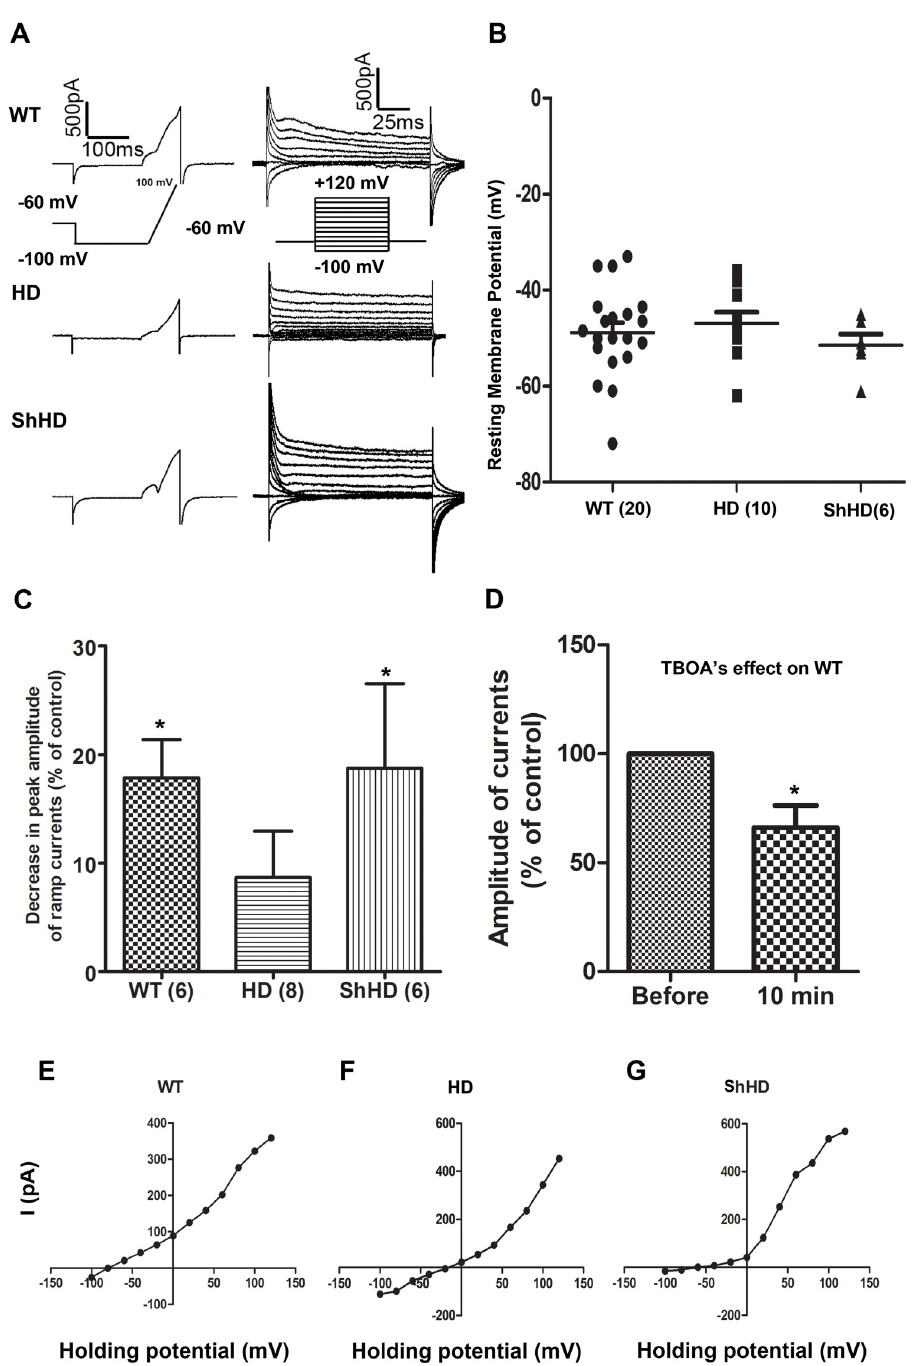
Fig 5. Functional characterization of differentiated astrocytes. (A) Representative traces of ionic currents evoked by ramp protocol (left) and voltage-step protocol (right) in cultured WT, HD, and shHD astrocytes. The holding potentials for all the cells were -60mV. (B) Plots of resting membrane potential values for the three types of cells recorded before the current membrane activation. There is no statistical significance among three groups. (C) Percentage of ramp current decrease measured at +100 mV by application of 4-AP (500 uM) in the superfusion medium during recordings on all three types of astrocytes. (D) Significant decreases in the amplitude of peak ramp currents were observed in WT astrocytes following 20 min application of TBOA at the concentration of 500 uM (n = 6). (E, F, G) I/V plots show that all three types of astrocytes share the similarity with variably rectifying astrocyte reported in the literature. However, the reversal potential of (F) HD astrocytes was significantly shifted compared